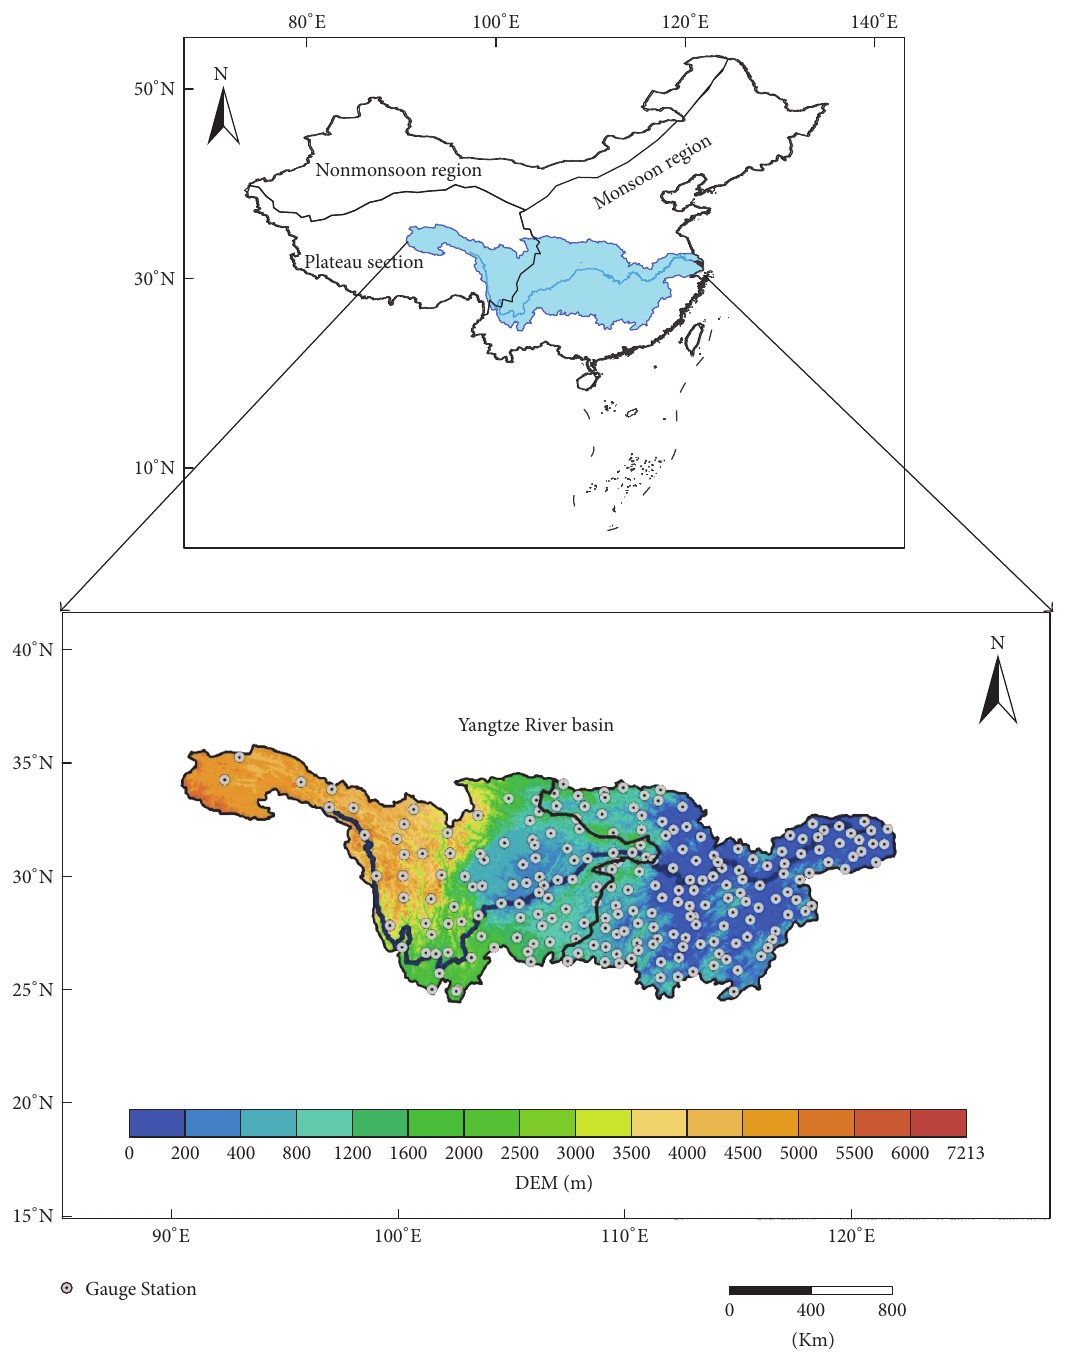
Figure 1: Location of the Yangtze River basin and gauge